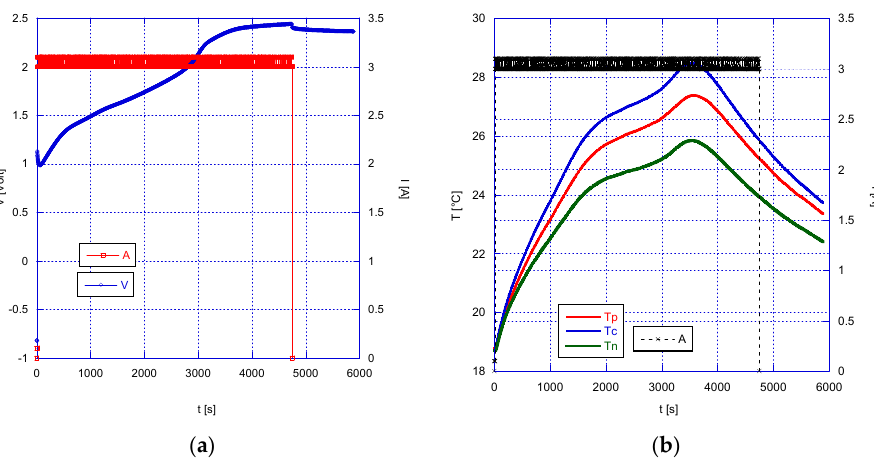
Figure 14. LTO cell. Recharge of the cell after overdischarge (DOD% = 140%): ( a ) voltage vs. time; ( b ) temperature and current vs. time.